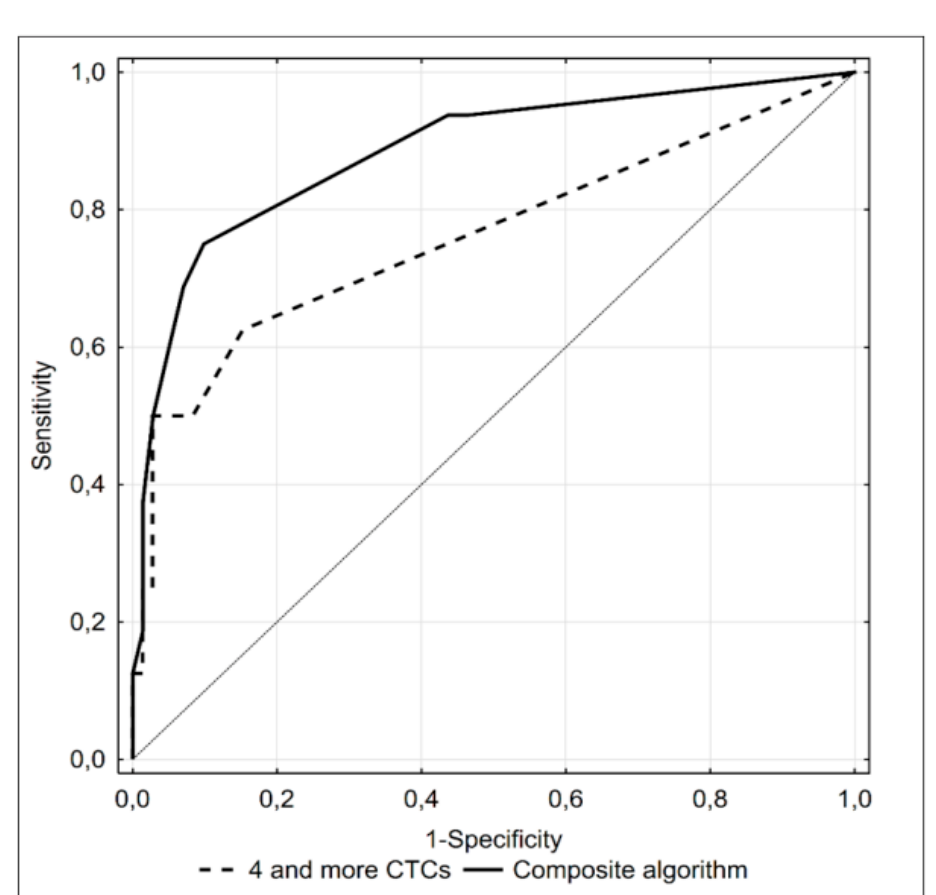
Figure 4. ROC curve illustrating diagnostic accuracy of ≥ 4 CTCs detected with the CellSearch ® system (dotted line) and a composite algorithm including this parameter, concentration of PSA > 25 ng / mL, Gleason score equal to 9 points and cT > 2C as predictors of bone metastases (black line) in prostate cancer patients.